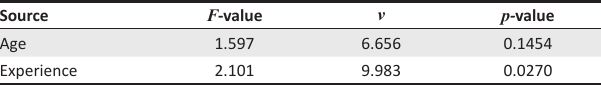
TABLE 7: MANOVA F values for testing the main effects on the Maslach Burnout Inventory